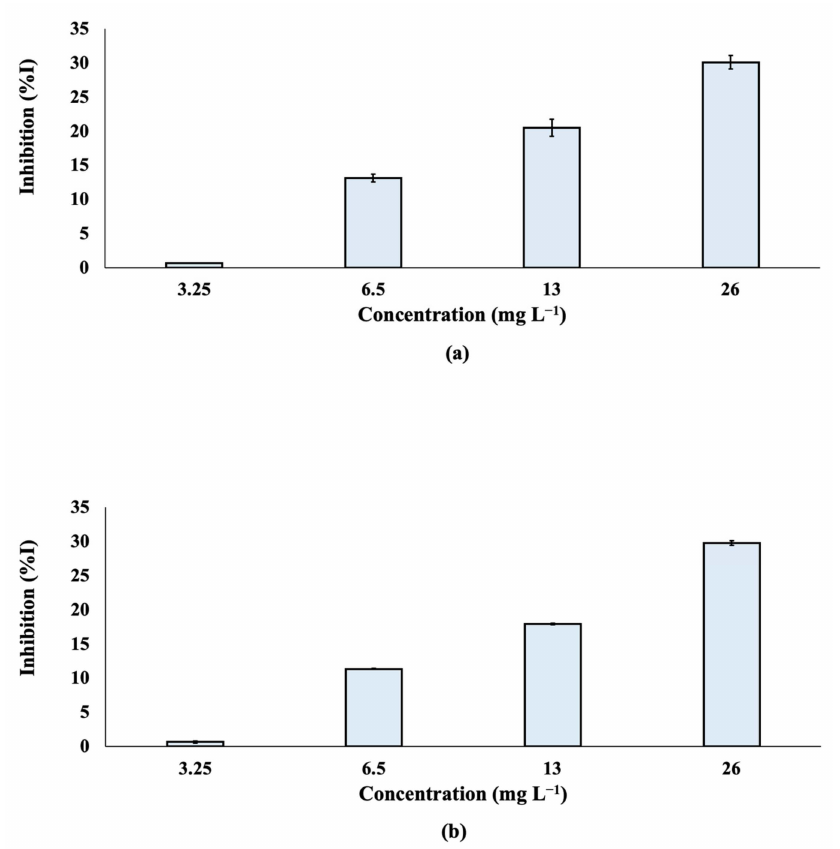
Figure 5. % Inhibition of bioluminescence of Aliivibrio fischeri after ( a ) 5 min and ( b ) 15 min of exposure to